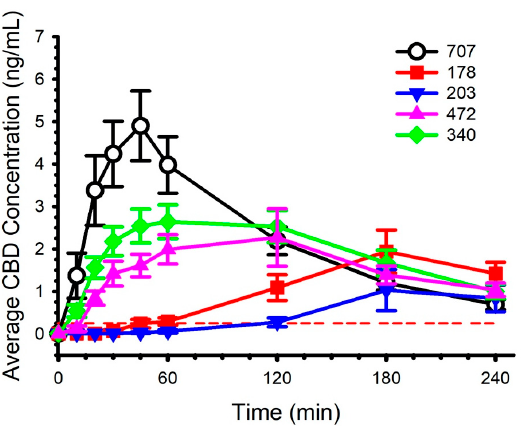
Figure 2. Circulating cannabidiol (CBD) concentration following ingestion of five different preparations. Dose was standardized to 30 mg. Limit of quantitation was 0.25 ng/mL and is represented by the red dashed line. Data are mean and standard error.